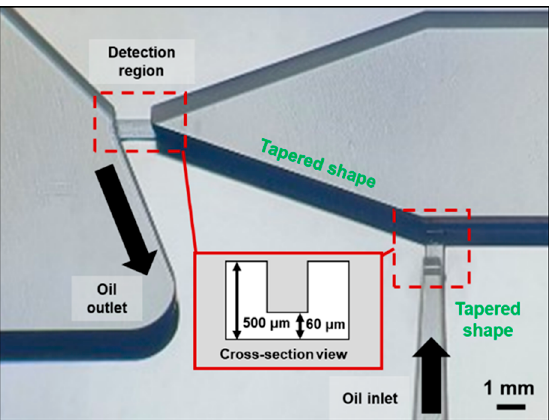
Figure 4. Optical photograph of the relatively small volumetric points (detection region and oil inlet) on the SU-8 mold.